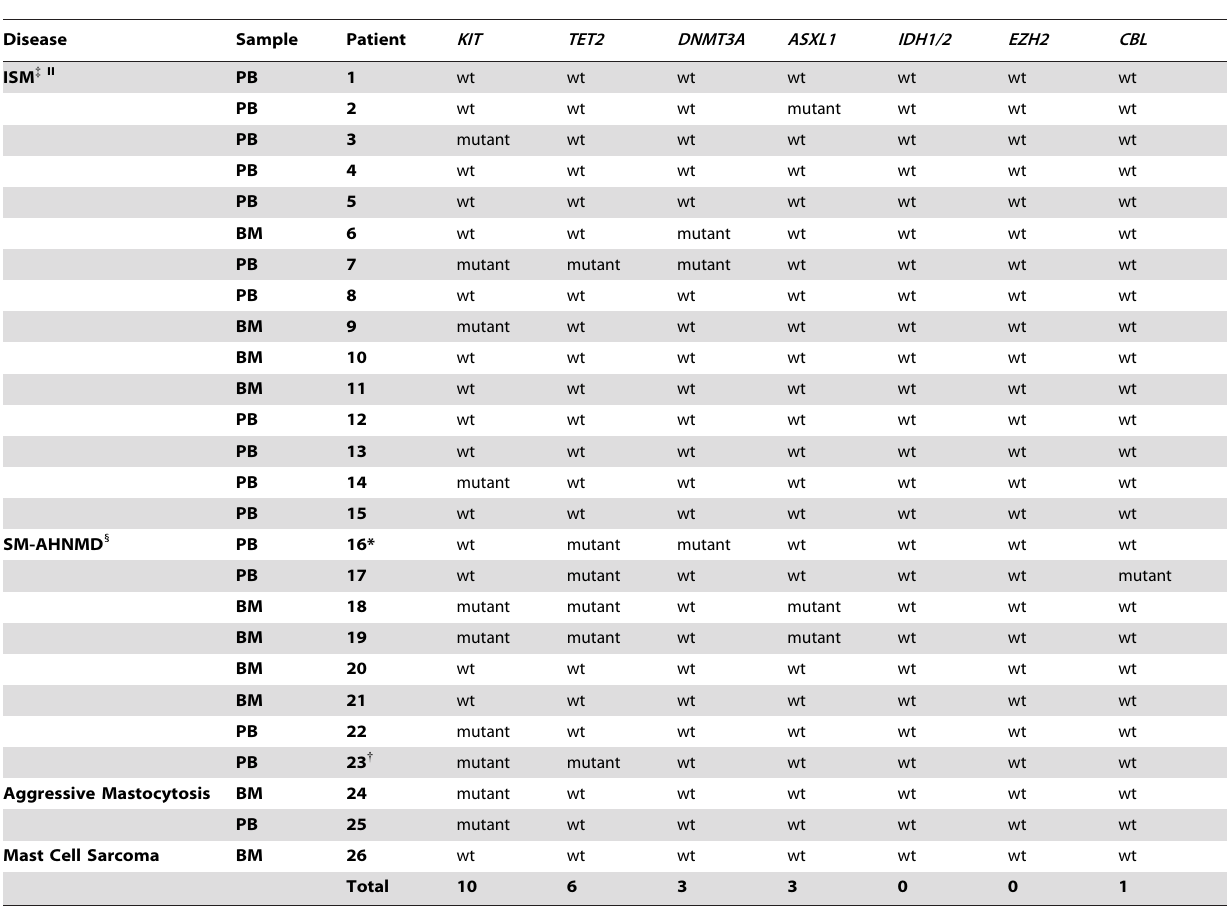
Table 2. Mutational status in patients with systemic mastocytosis.